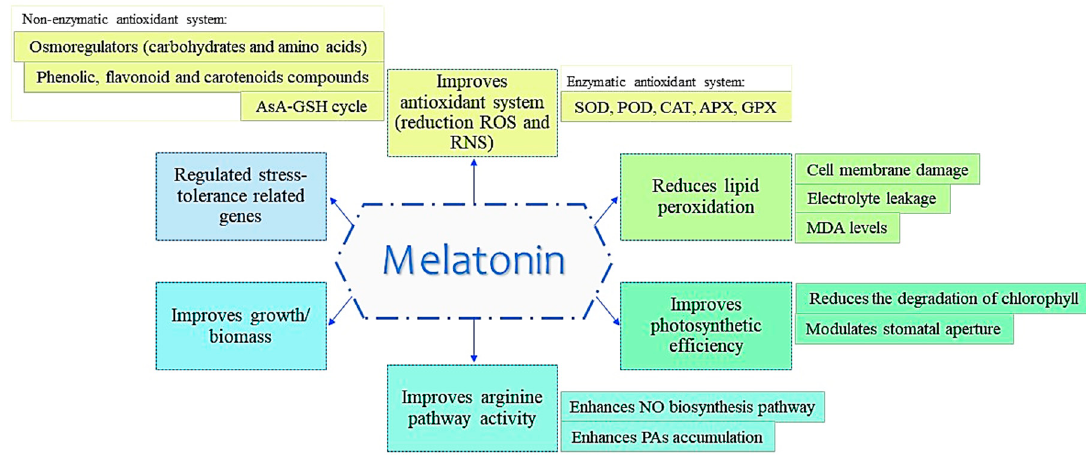
Figure 5. Common MET functions in abiotic stress tolerance.